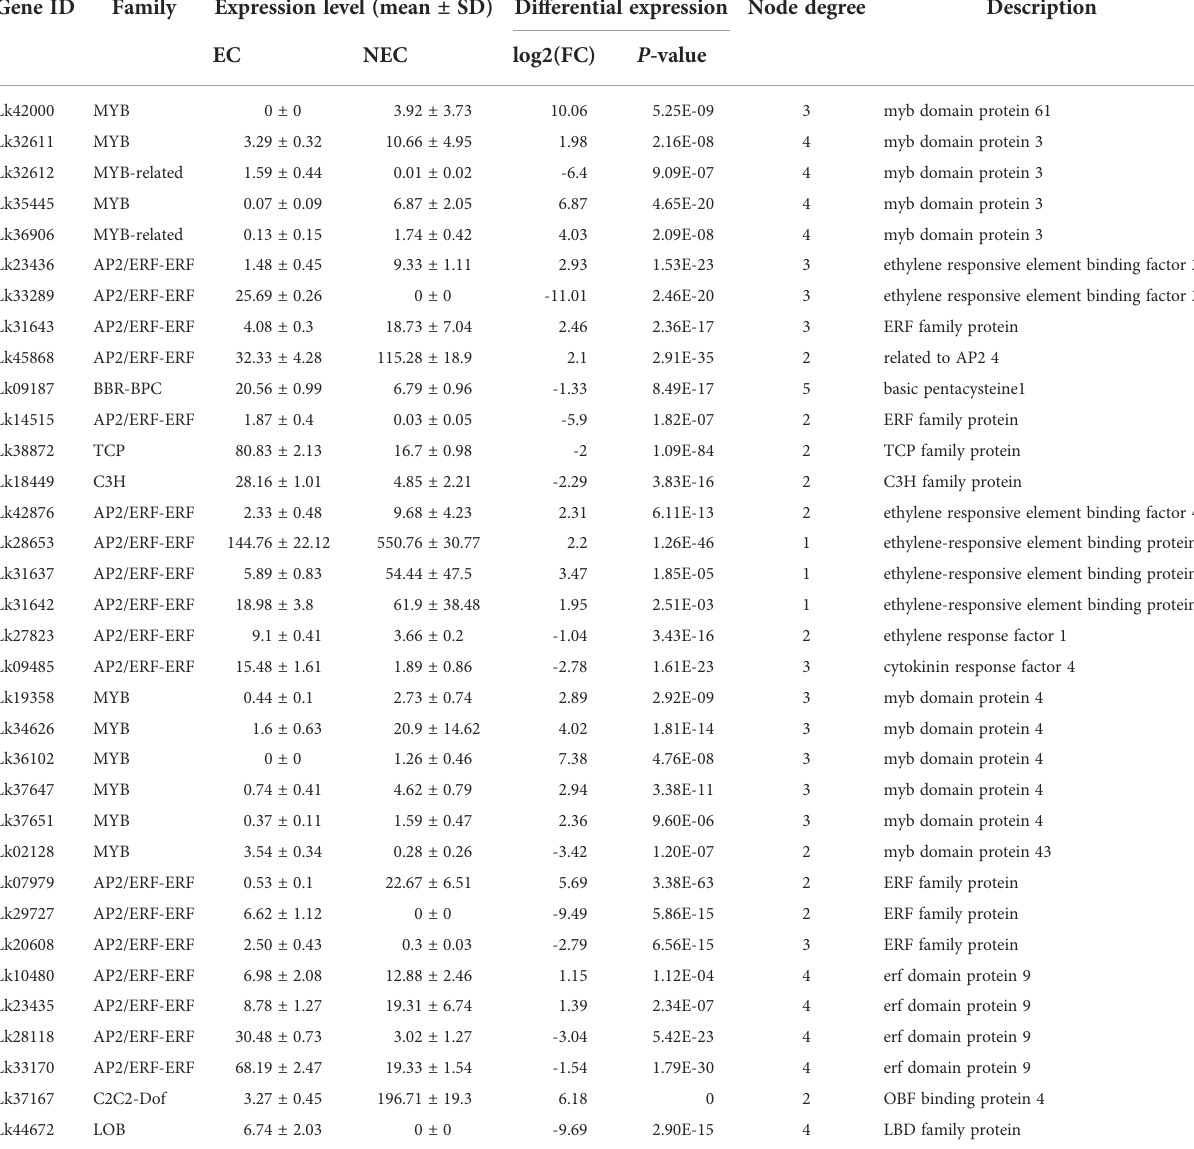
TABLE 4 The expression and annotation of candidate TFs regulating structural genes involved in fl avonoid and phenolic acid biosynthesis. Gene ID